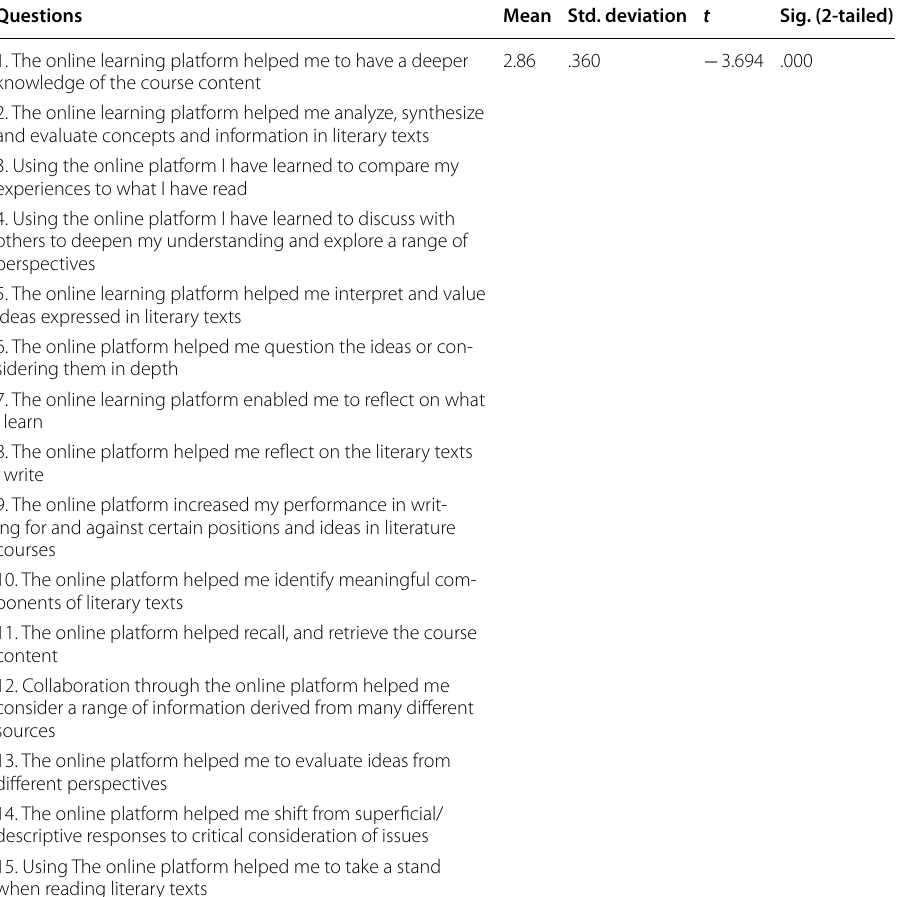
Table 3 English literature student’ perceptions towards reflective thinking in their online learning